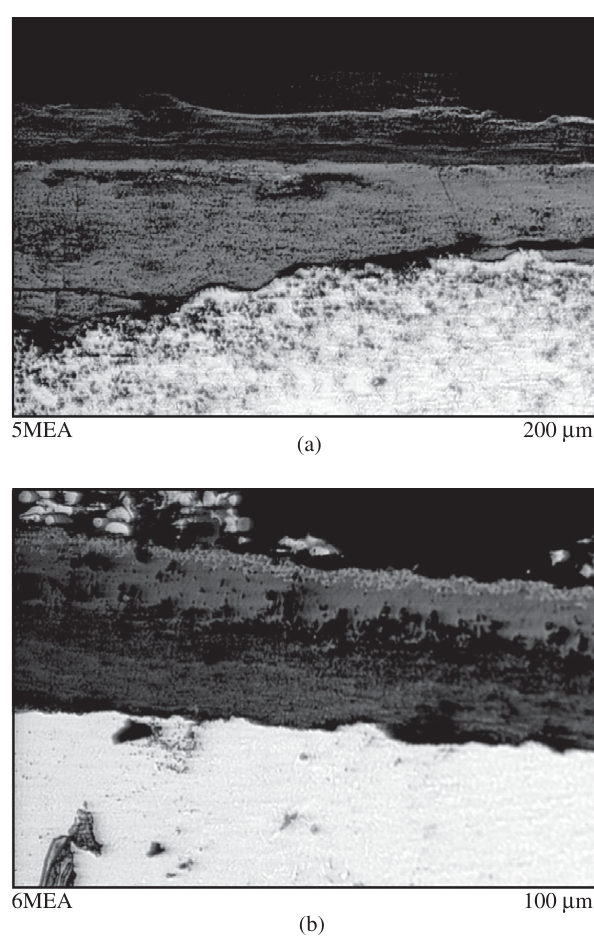
Figure 6. Morphology of oxide scales formed in service in a steam environment: a) T22 after 19000 h at 550 °C; b) 9Cr1Mo